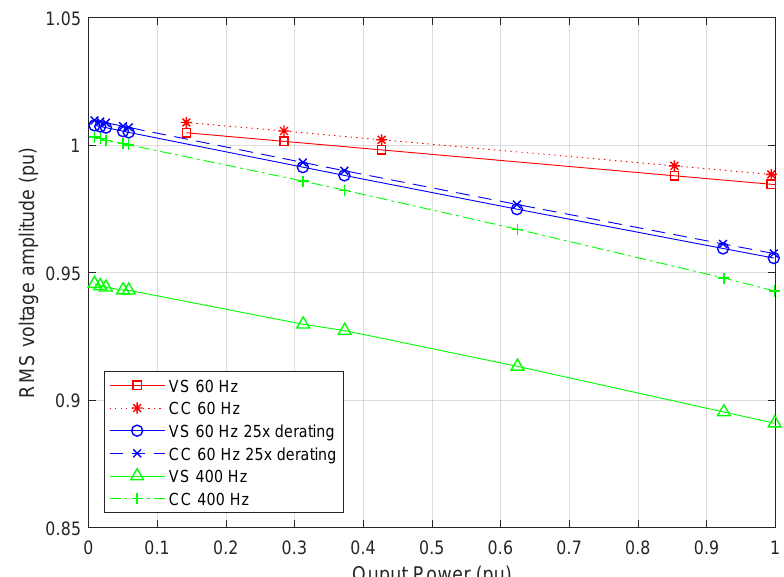
Figure 10. Simulated droop characteristics for voltage-sourced (VS) vs. current-controlled (CC) inverters for two different nominal ratings at 60 Hz and and one rating at 400 Hz. As expected, the two equivalent VS and CC formulations perform almost exactly the same for both ratings at 60 Hz, but they diverge at 400 Hz because it is beyond the current controller bandwidth shown in Figure